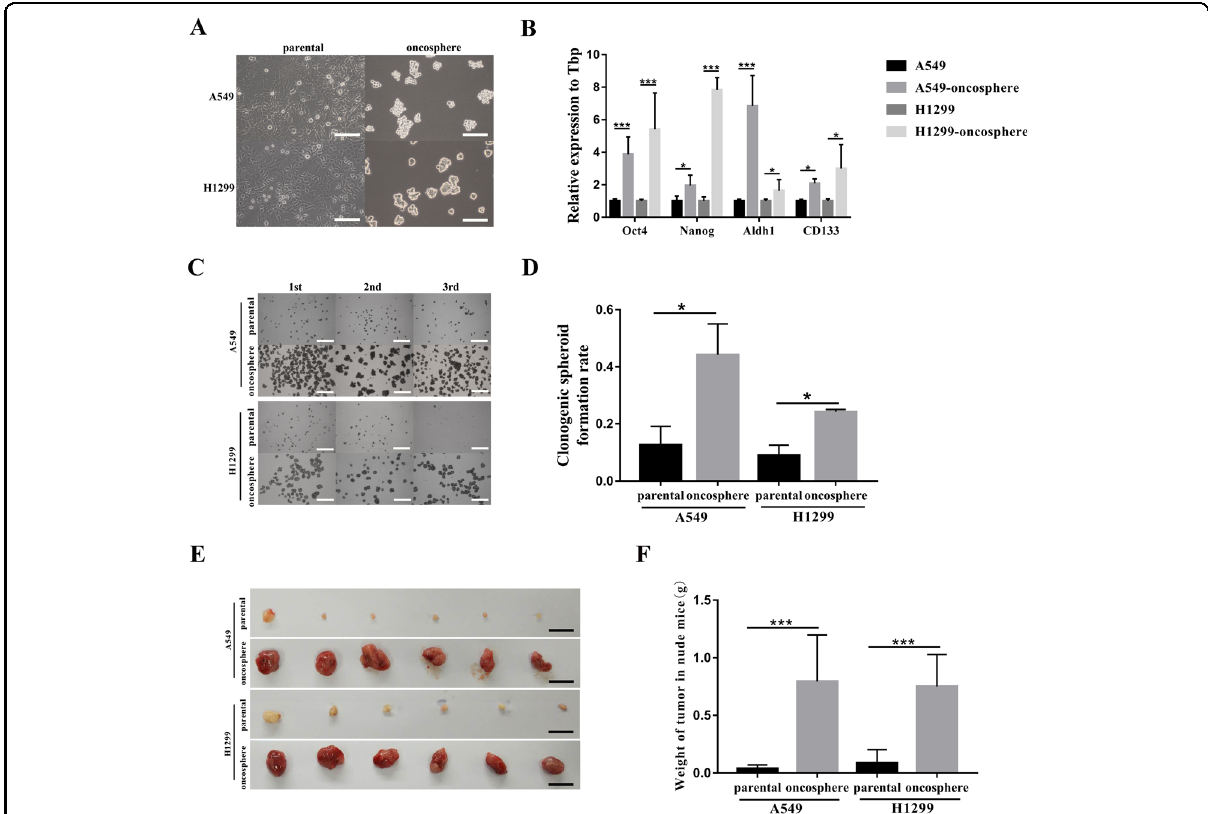
Fig. 1 Generation and characterization of CSC cell lines derived from A549 and H1299 parental cell lines. A The morphology of A549, A549- oncosphere, H1299, and H1299-oncosphere, bar = 120 µm. B Analysis of mRNA expression of Oct4, Nanog, Aldh1, and CD133. Tbp expression was used as a reference control. * p < 0.05, *** p < 0.01. C Consecutive spheroid formation assay, 1st means single-cell suspensions were plated at 1000 cells/well, 2nd means spheroid cultures were then collected from 1st and single-cell suspensions were prepared for setting up the second round